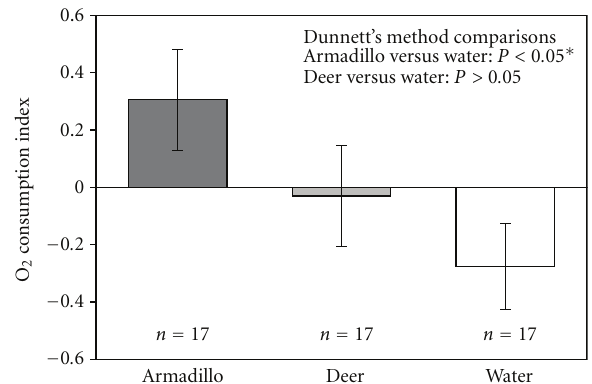
Figure 5: Experiment 3: physiological responses to substrate cues. Oxygen consumption index by salamanders exposed to stimuli from armadillos, deer, or blank control water in a closed chamber for 12min. Bars and error bars represent means ± 1 SE. The asterisk represents statistical significance. Index = residuals of log-transformed oxygen consumption ( µ L) regressed against log- transformed mass